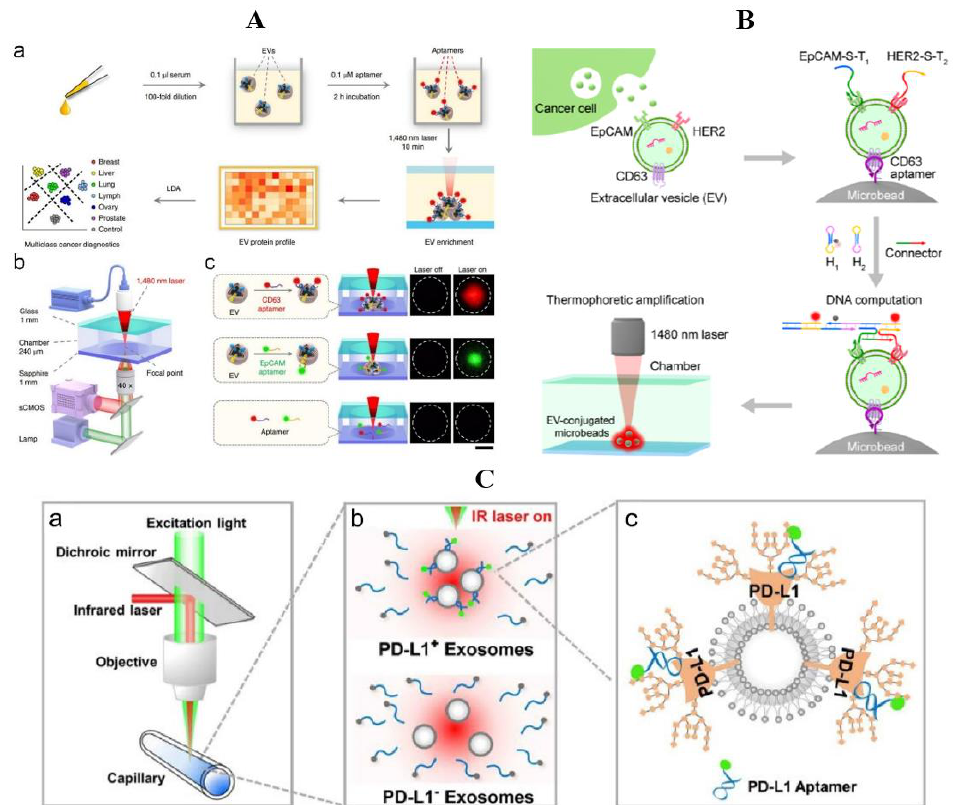
Figure 4. Thermal electrophoresis combines aptamers in the fluorescence method. (A) Overview of TAS for the profiling of surface proteins of EVs: a) schematic of the TAS procedure. Using a panel of seven aptamers, the protein signatures of EVs in 0.1 μL human serum were profiled by TAS and used for multiclass cancer diagnostics. b) Schematic of the setup of TAS. The 1480 nm infrared laser beam was focused onto the bottom of the microchamber for EV accumulation. sCMOS, scientific complementary metal oxide semiconductor. c) Schematic of TAS for the enrichment and detection of aptamer-bound EVs. An amplified fluorescence signal was observed for aptamer-bound EVs after thermophoretic concentration. Owing to small sizes, free aptamers cannot be enriched. The working area is indicated by a dashed circle with a diameter of 100 μm. Scale bar, 50 μm [96]; (B) schematic of thermophoresis-mediated DNA computation on EV membranes [98]; (C) working principle of HOLMES-ExoPD-L1 analysis [99].